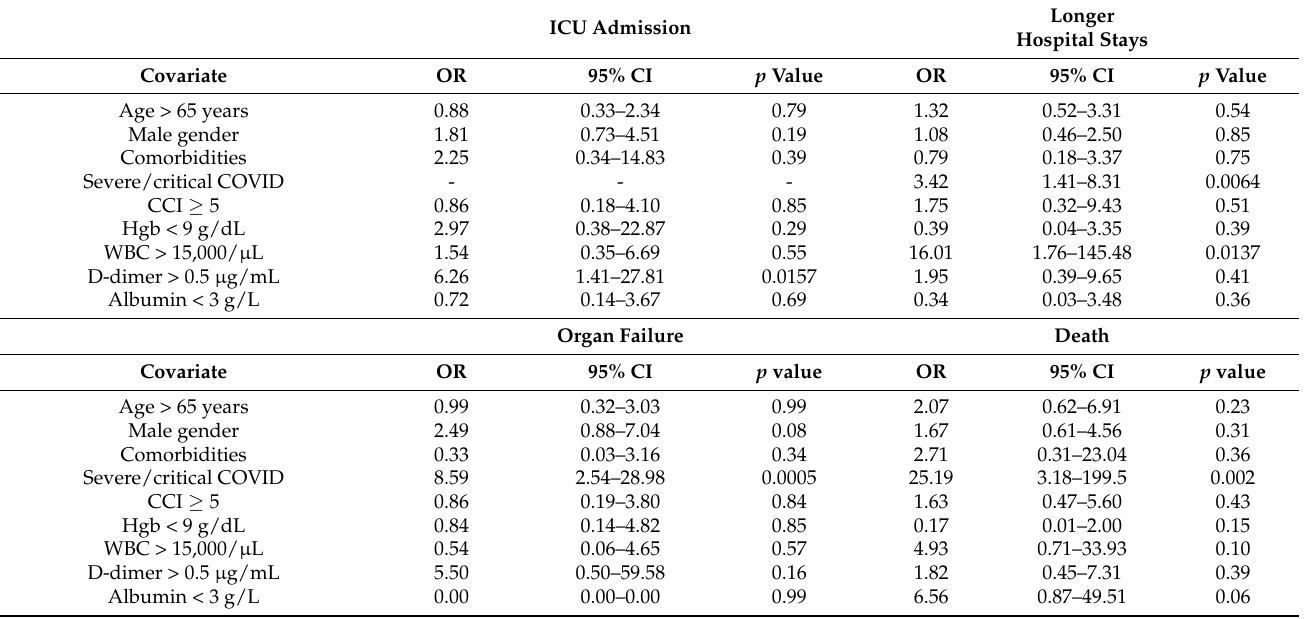
Table 4. Multivariate analysis of risk factors for poor prognosis in CDI-COVID-19